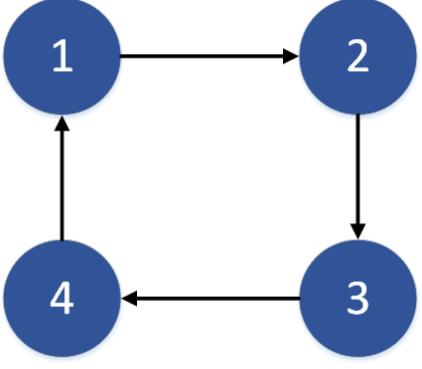
Figure 2. Four-generator system communication topology.